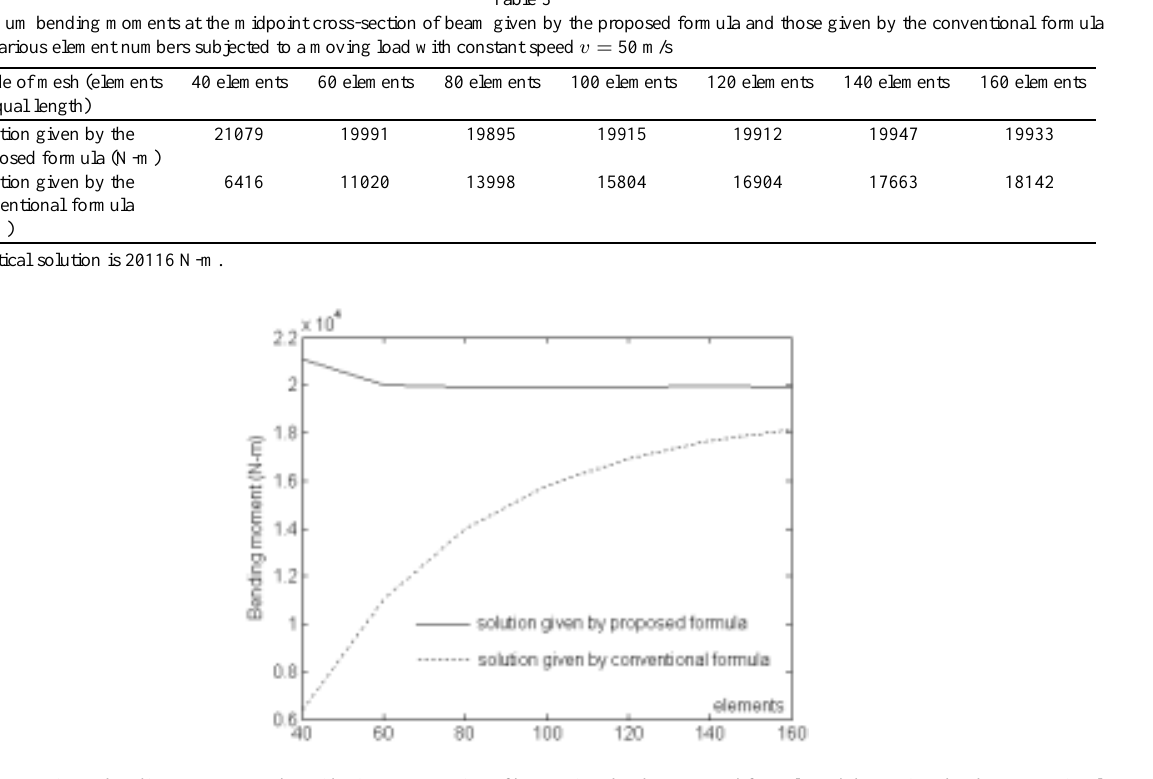
Fig. 14. Maximum bending moments at the midpoint cross-section of beam given by the proposed formula and those given by the conventional formula with various element numbers subjected to a moving load with constant speed v = 50 m/s. s = λ ( x − vt ) (cid:9) β = ω ¯ m/k 1 b w ¯ δ ( s ) = δ ( x )